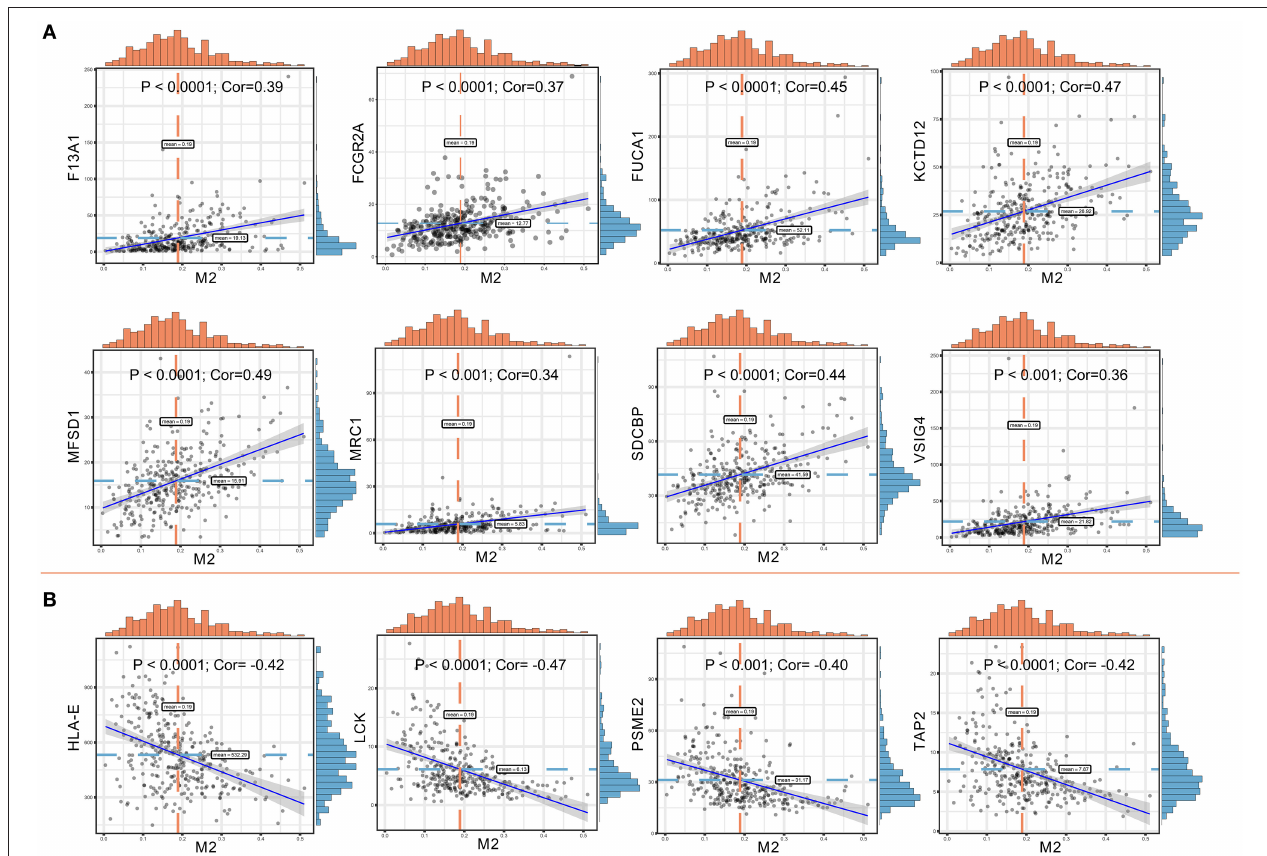
FIGURE 6 | (A) Co-expressed genes with a significant positive correlation with M2 macrophages. The correlation coefficients are as follows: F13A1 – M2: Cor = 0.39; FCGR2A – M2: Cor = 0.37; FUCA1 – M2: Cor = 0.45; KCTD12 – M2: Cor = 0.47; MFSD1 – M2: Cor = 0.49; MRC1 – M2: Cor = 0.34; SDCBP – M2: Cor = 0.44; VSIG4 – M2: Cor = 0.36. (B) Co-expressed genes with a significant negative correlation with M2 macrophages. The correlation coefficients are as follows: HLA-E – M2: Cor = − 0.42; LCK – M2: Cor = − 0.47; PSME2 – M2: Cor = − 0.40; TAP2 – M2: Cor = − 0.42.